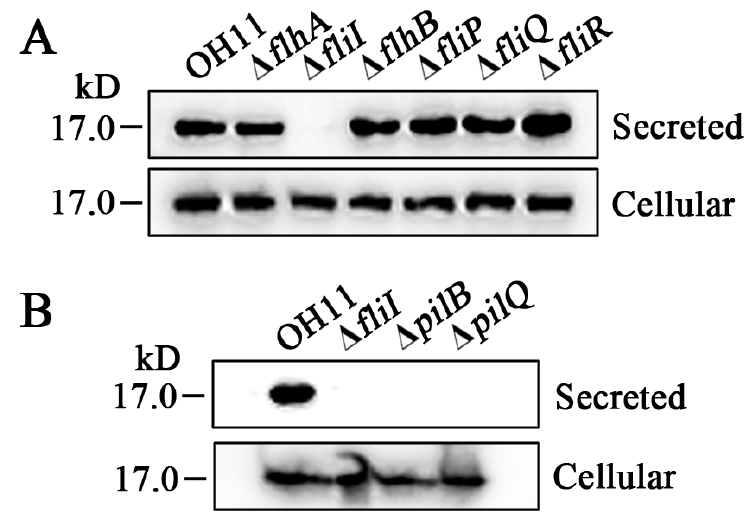
Figure 3. Differential contribution of FT3SS components to the secretion of PilA, the major pilin of type IV pilus in the non-flagellated L. enzymognes OH11. ( A ) Western blotting showing inactivation of FliIfully blocked PilA secretion. The coding gene of PilA was fused with a Flag-tag and introduced into wild-type OH11 and the FT3SS-defective mutants ( Δ flhA , Δ fllhB , Δ fliI , Δ fliP , Δ fliQ , or Δ fliR ). Strains were cultivated in 1/10 TSB, and cells were collected at OD 600 , 1.5. Except for the fliI mutant ( Δ fliI ), the signal of PilA-Flag determined by anti-Flag antibody was detected both in the culture supernatant of wild-type OH11 and the remaining five mutants, while cellular presence of PilA-Flag was observed in all test strains. ( B ) Western blot verification of PilA secretion was dependent both on the FliI and on two other pilus apparatus proteins, PilB (a pilus ATPase that provides energy via ATP hydrolysis to promote pilus extension) and PilQ (which forms an outer membrane secretin pore comprising multiple monomers to facilitate pilus extraction).